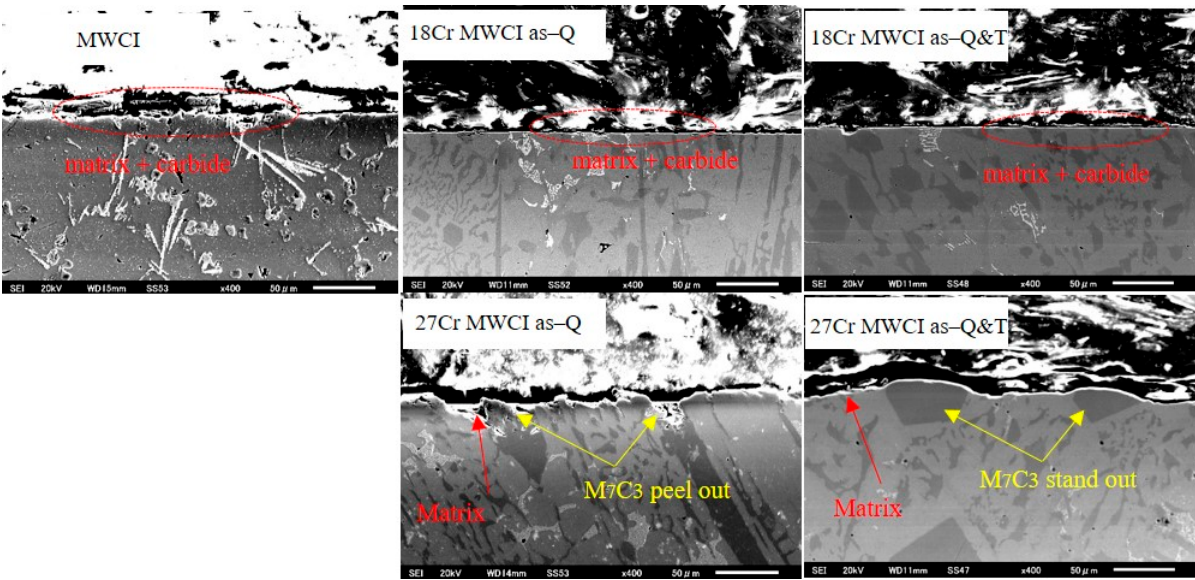
Figure 11. Cross-sectional condition of each material after three-body abrasive wear test.